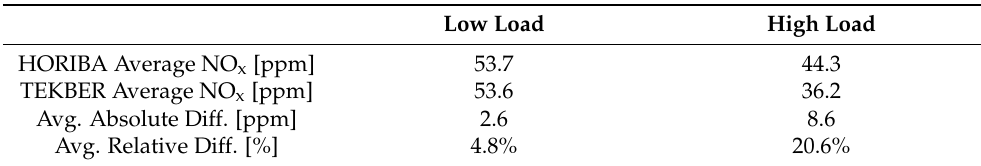
Table 2. Summary of average concentrations and differences for the Static Idling Internal Load Test with EGR.